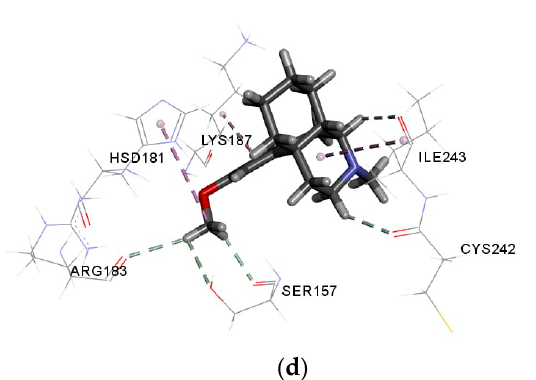
Figure 3. Interactions of ( a ) cis-verbenyl acetate, ( b ) β -elemene, ( c ) linalool, and ( d ) DEX (control) with NO receptor .